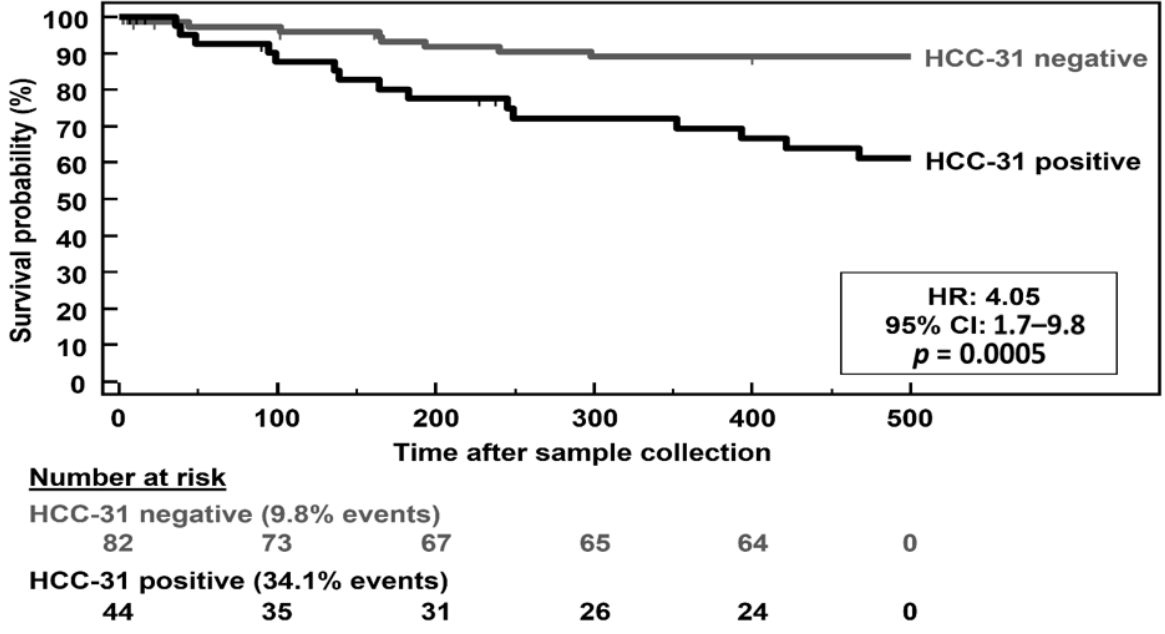
Figure 1. ROC characteristics of the proteomic HCC classification model HCC-31 on the validation set of 39 HCC cases and 87 non-HCC liver diseased controls.